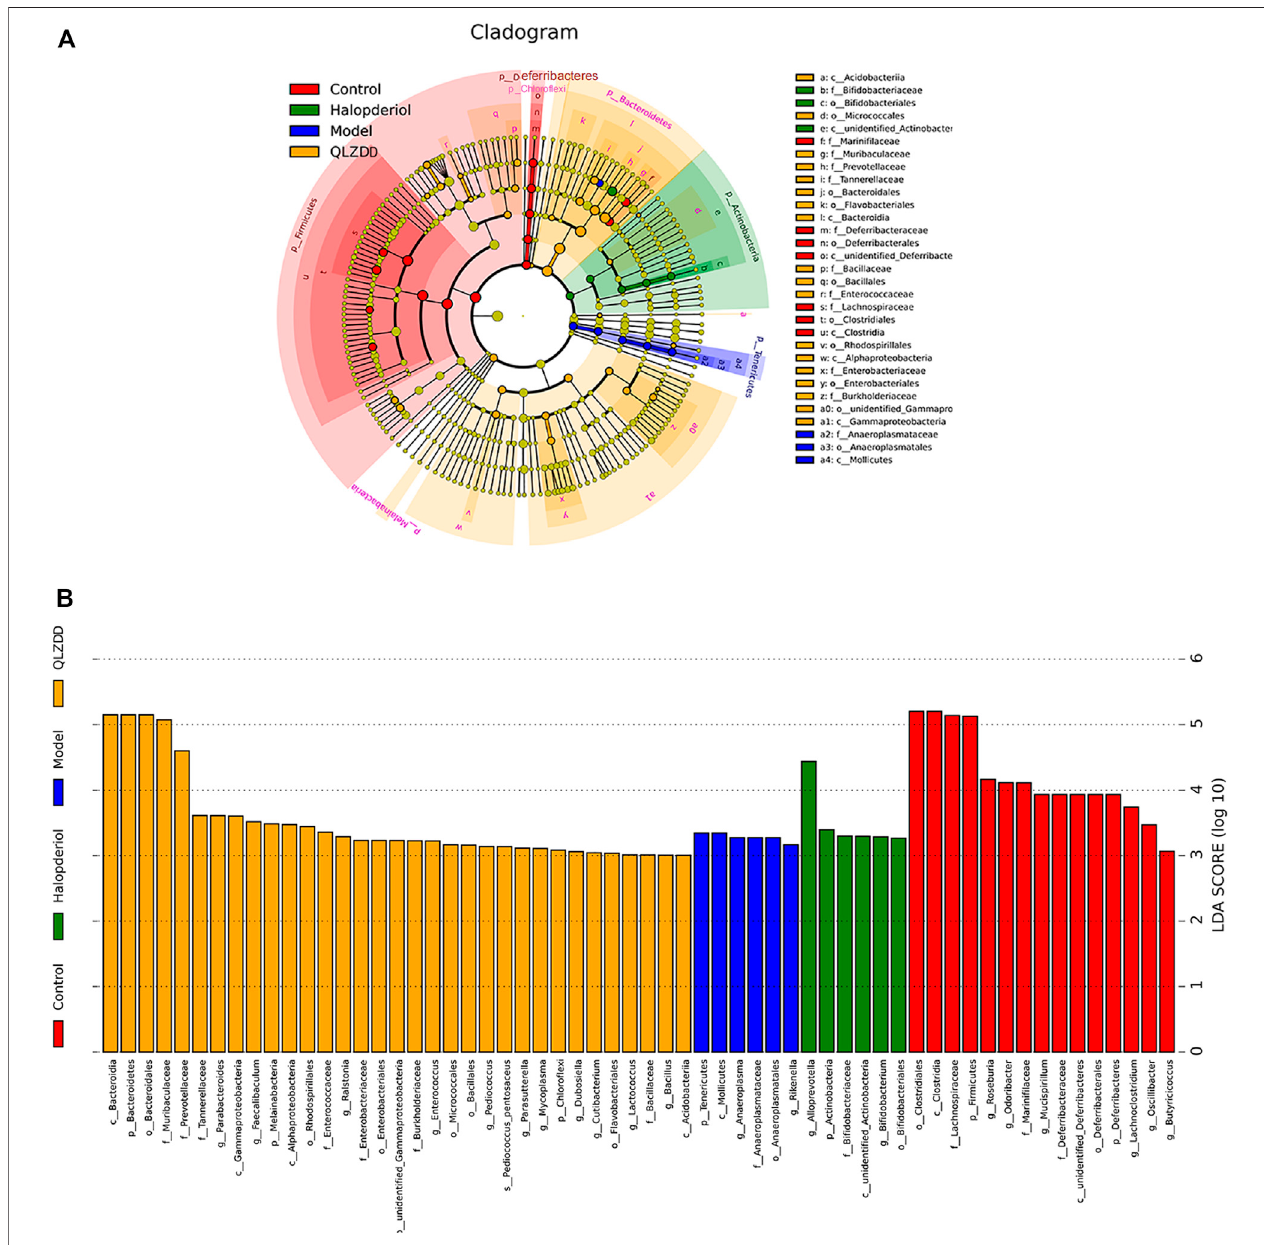
FIGURE8| LEfSeanalysisrevealedthespeci fi cgutmicrobiota. (A) LEfSeanalysisofevolutionarybranchinggraphs.Thecircleofevolutionarybranchingmapsfrom internal to external radiation represents the classi fi cation level from the phyla to the species. A signi fi cant value of less than 0.05 was used as a threshold for the LEfSe analysis. (B) The LDA score obtained from LEfSe analysis of gut microbiota in different groups. A LDA effect size of more than 3 was used as a threshold for the LEfSe analysis.